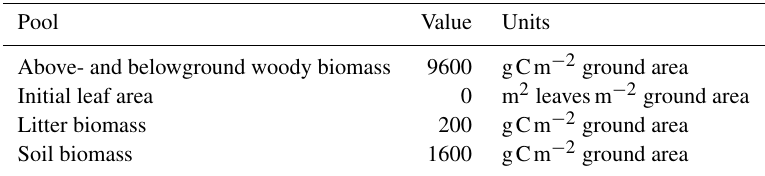
Table A1. Initial state values used for SIPNET